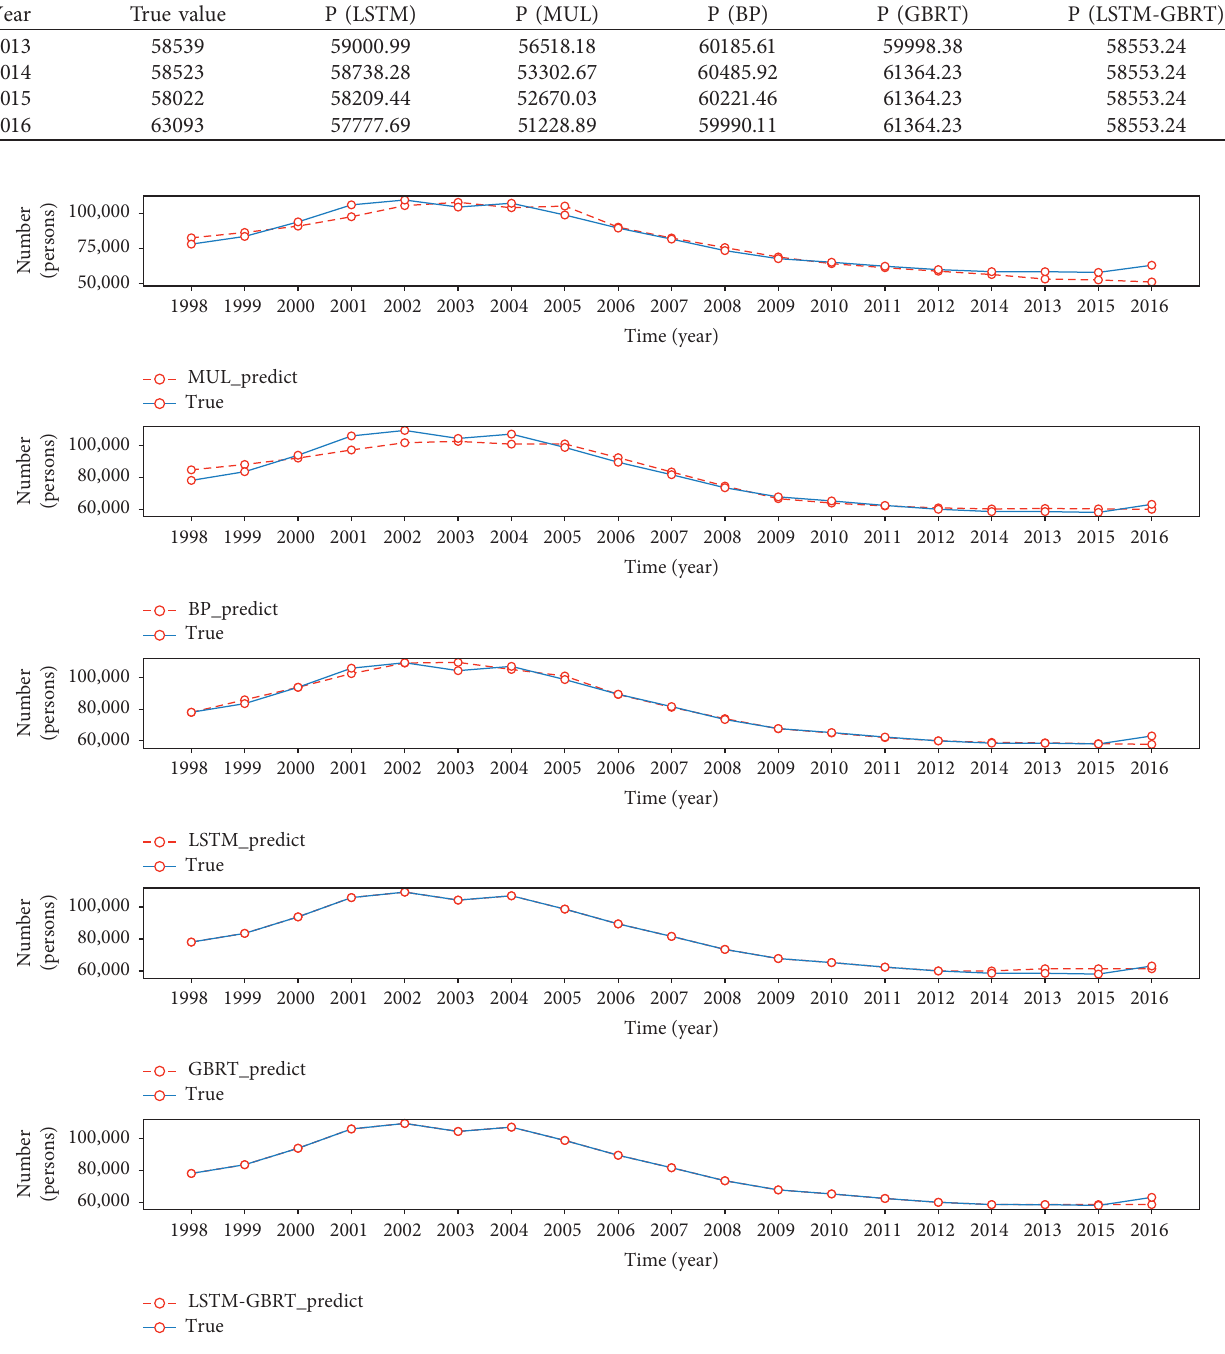
Figure 5: Fitting prediction results for each